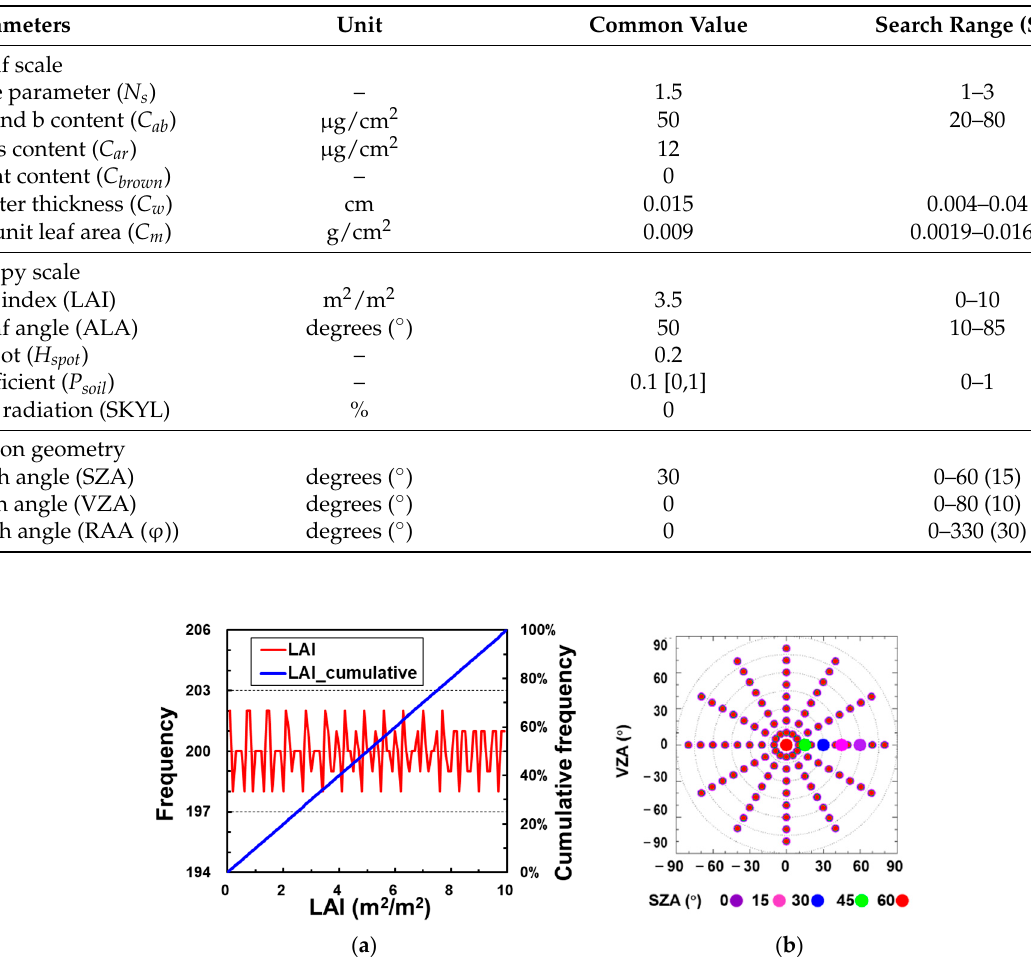
Table 1. The input parameters of the PROSAIL model.